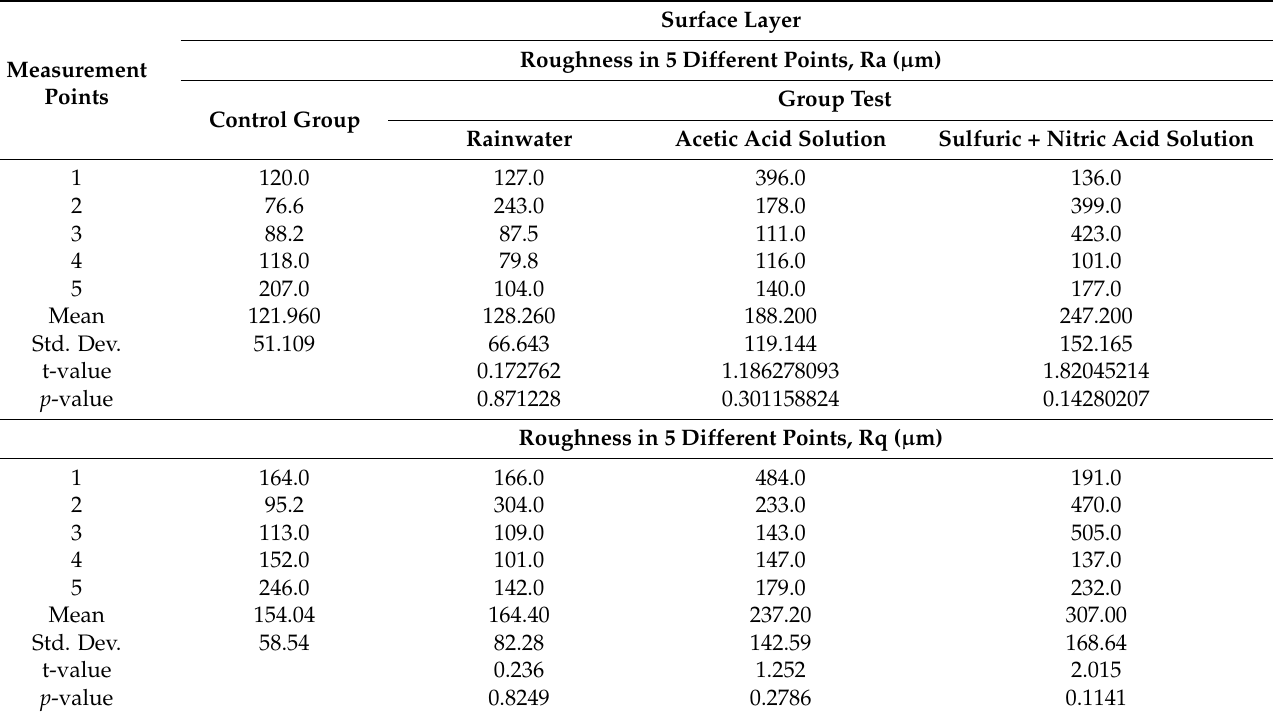
Table 2. The roughness table for surface